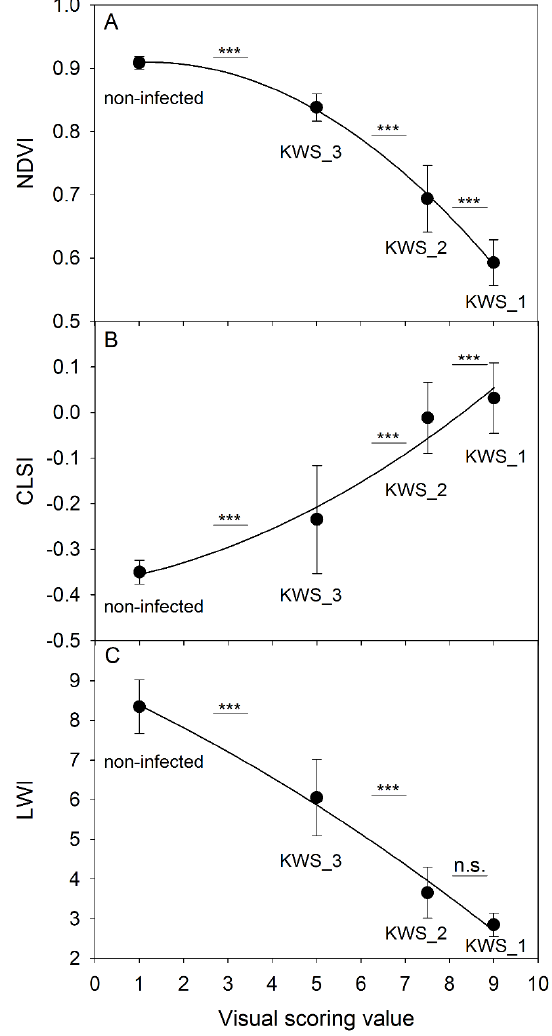
Figure 4. Field spec measurements. Vegetation indices were calculated out of measured spectral data and correlated with visual disease scoring values of CLS infected as well as infection-free sugar beet plants. ( A ) NDVI; ( B ) CLSI; ( C ) Leaf Water Index (LWI); Regressions were calculated using 2nd degree polynomial fits. Significant differences between index data of non-infected plants and diseased plants of genotypes KWS_1, KWS_2, and KWS_3 are denoted with *** ANOVA, p <